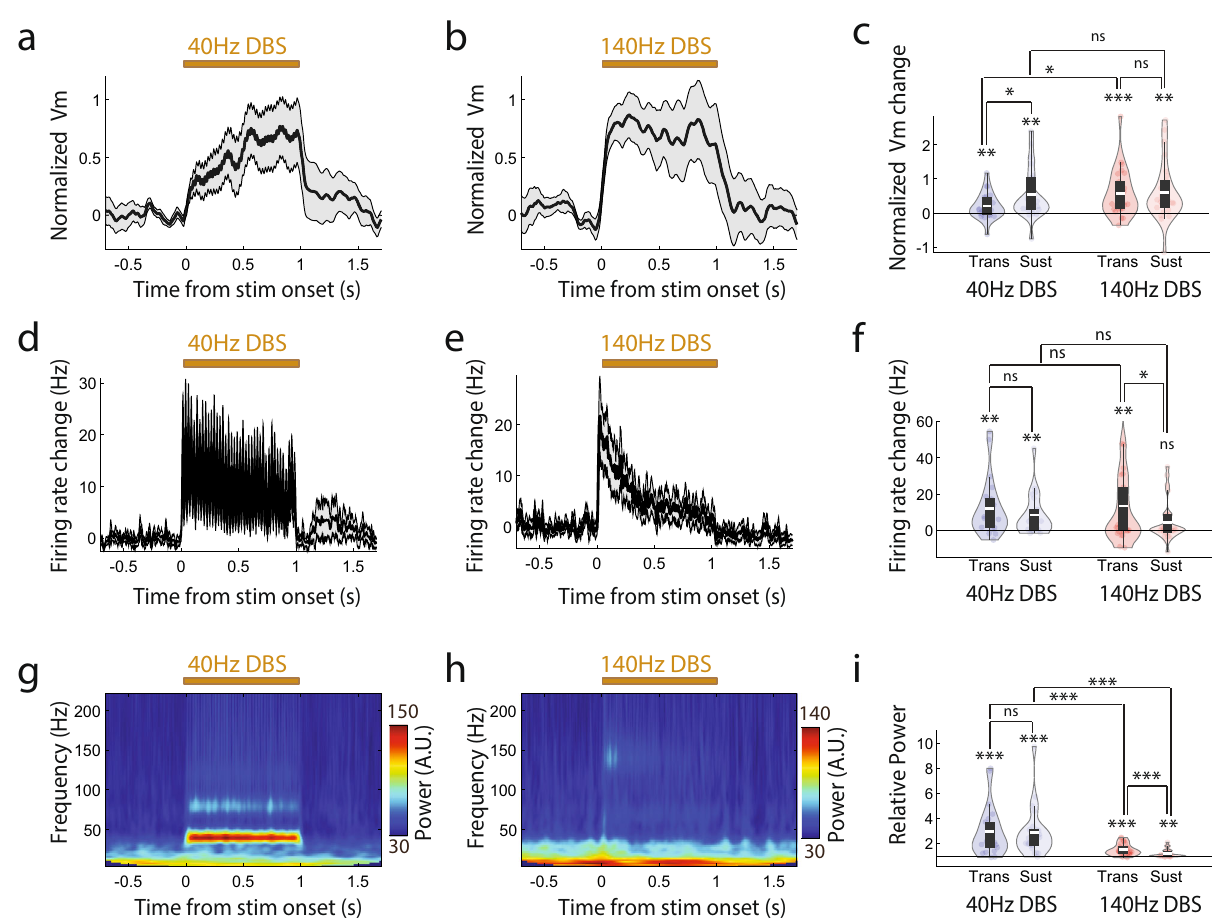
Fig. 2 | DBS induces powerful membrane depolarization at both 40Hz and 140Hz. a-c Amplitude of the subthreshold membrane potential (Vm) and corre- spondingquanti fi cations. a,b Population-averagedVmduring40HzDBS( a , n =22 neurons) and 140Hz DBS ( b , n =26 neurons). Vm is calculated as the fl uorescence at each time point divided by the averaged amplitude of all spikes detected in a recording session for a given neuron. DBS-induced Vmchanges werecomputedas normalized Vm by subtracting the mean of the Vm during the pre-stimulation baseline period. Shaded gray area is the standard error of the mean (SEM). c Quanti fi cation of Vm change from baseline during the transient (0 – 0.15s) and sustained (0.15 – 1s) periods of 40Hz and 140Hz DBS. Data are visualized as violin plots with the outer shape representing the data kernel density and box plots showinginterquartilerange(1x,1.5x).Thewhitelinesintheboxesarethemean.For 40HzDBS,pairedt-test,df=21neurons,transient: p =0.002;sustained: p =0.003, transient vs. sustained: p =0.0156. For 140Hz DBS, paired t-test, transient: p =3.1×10 − 4 , df=25; sustained: p =0.001, transient vs. sustained: p =0.78. Com- parison between 40Hz and 140Hz DBS, independent t-test, df=46, transient: p =0.045; sustained: p =0.79. d-f Spike rate and corresponding quanti fi cations. d, e Population-averaged spike rate during 40Hz DBS ( d, n =22) and 140Hz DBS